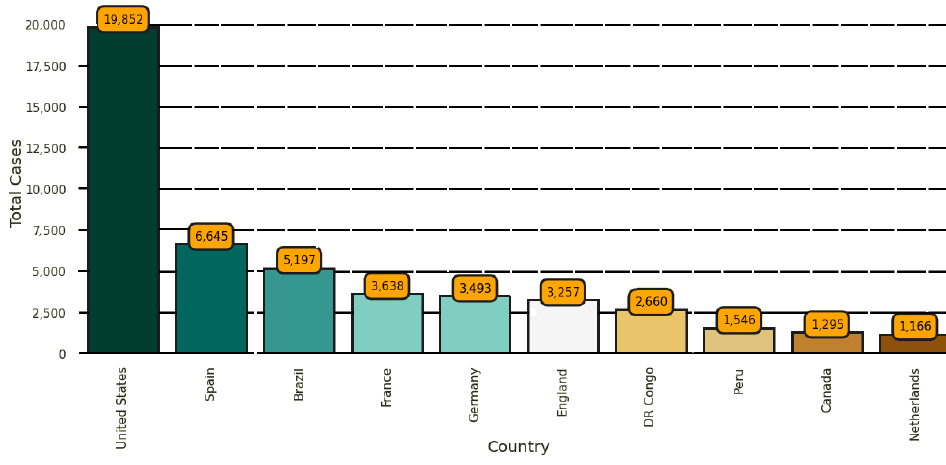
Figure 8. The countries contaminated with the monkeypox